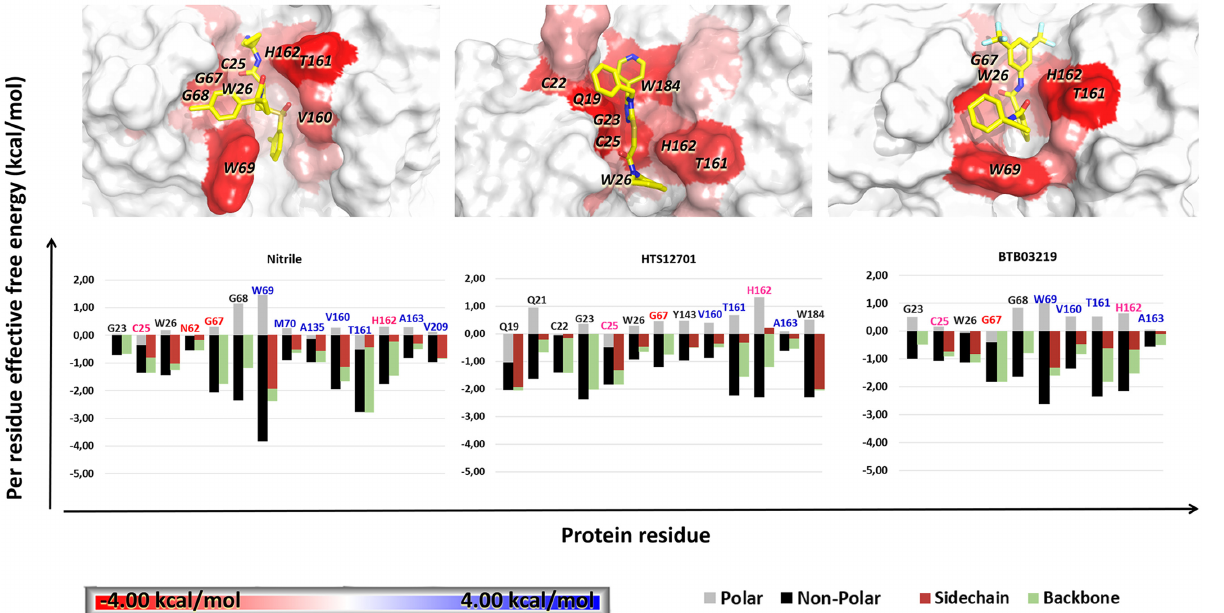
Fig 5. Per-residue free energy decomposition for FhCL3 complexes. Bar graphs show the side chain, backbone, polar and non-polar contributions for each residue. Residue names are colored according to their location within S1 (pink), S2 (blue) and S3 (red) subsites. A structural representation of each complex interface is depicted as well. Interacting residues are colored according to energy value as shown in color scale. Hot/warm-spots are labeled in each